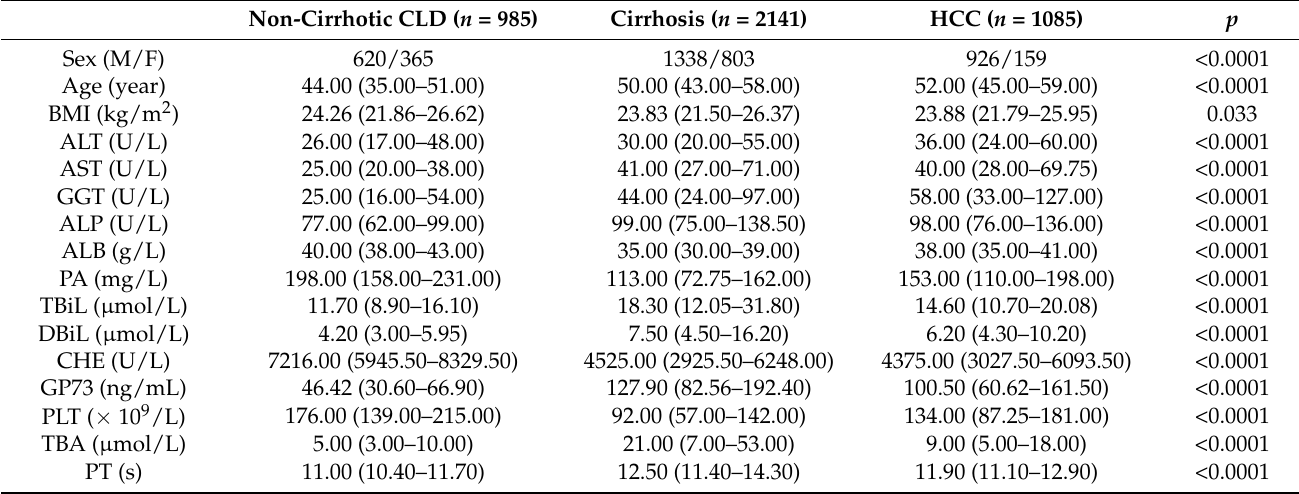
Table 1. Demographic and laboratory characteristics of the included 4211